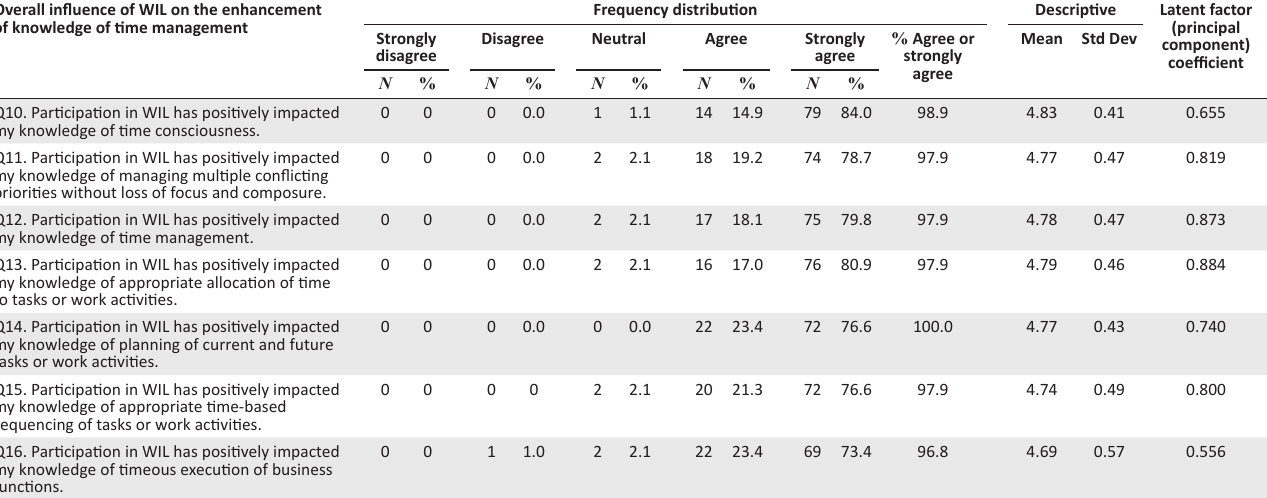
TABLE 3: Enhancement of knowledge of time management. Overall influence of WIL on the enhancement of knowledge of time